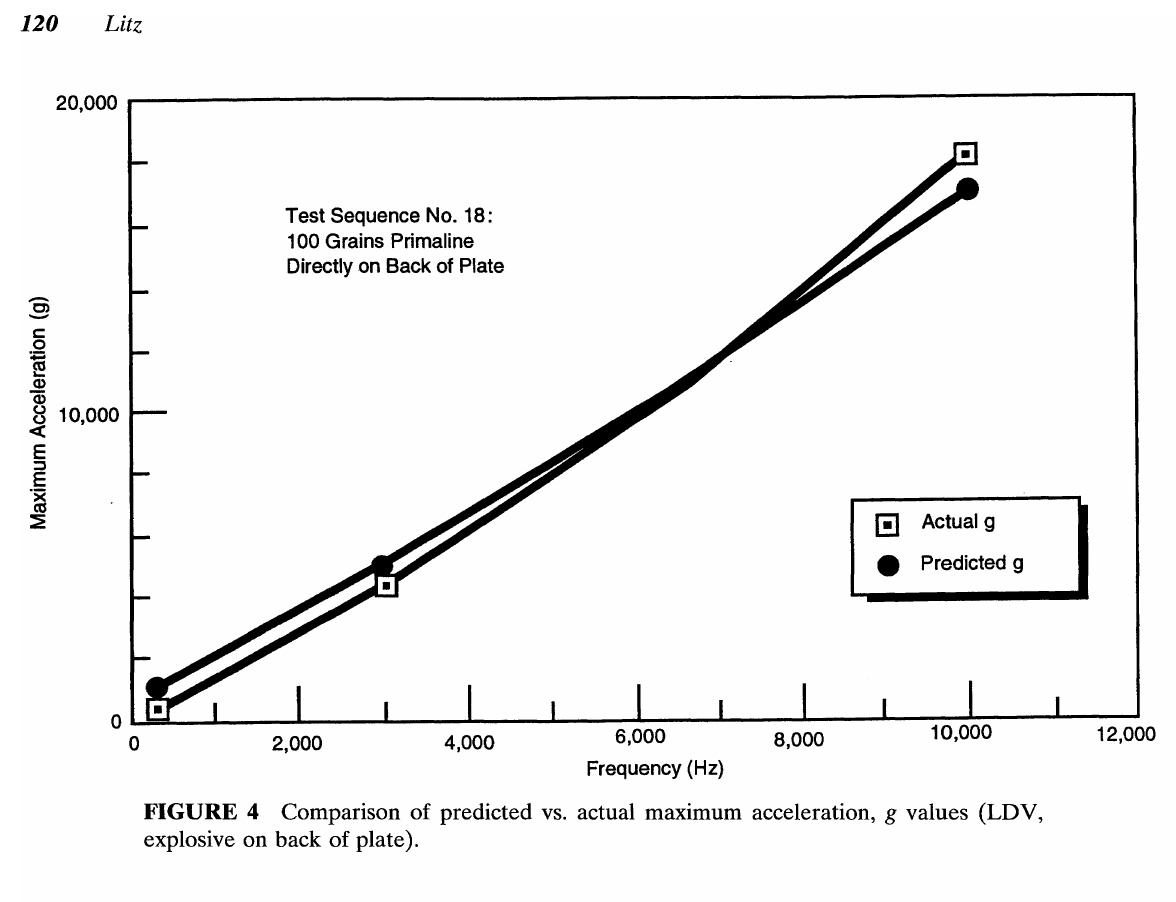
FIGURE 4 Comparison of predicted vs. actual maximum acceleration, g values (LDV, explosive on back of plate).